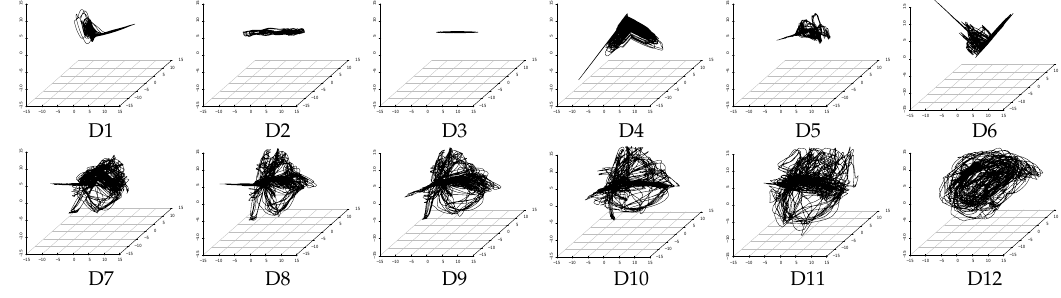
Figure 5. Three-dimensional time-series of latent features extracted from datasets D1 to D12 by PCA in the three-dimensional feature